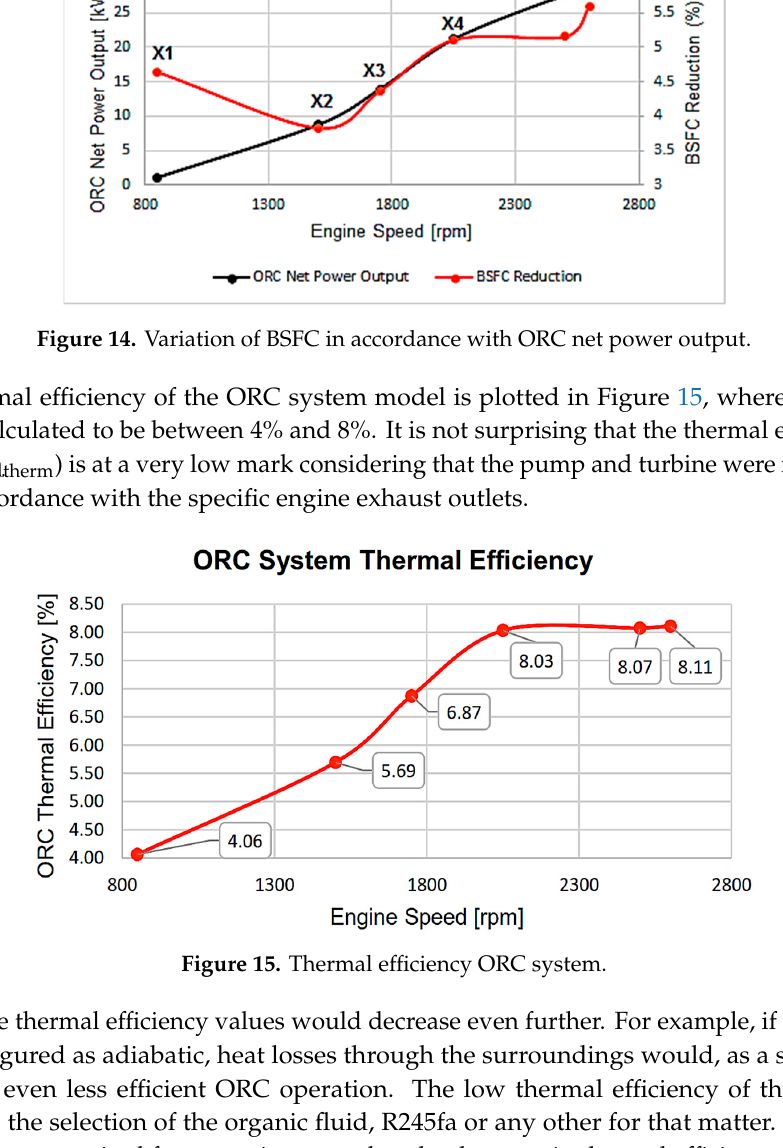
Figure 15. Thermal efficiency ORC system